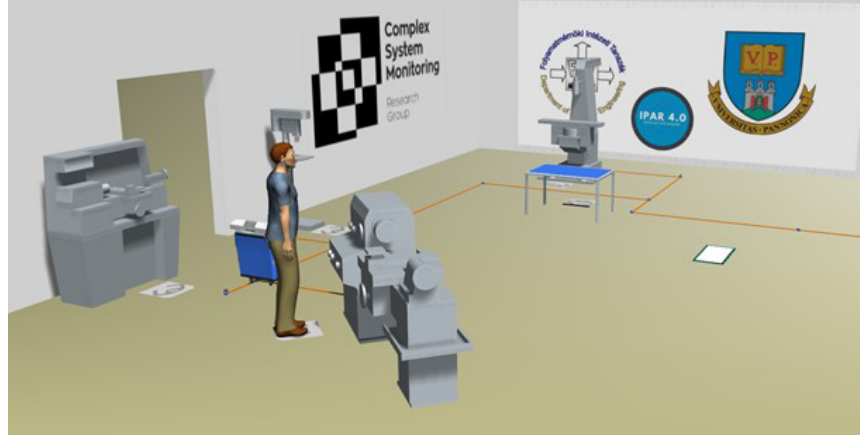
Figure 11. The digital twin of the laboratory.